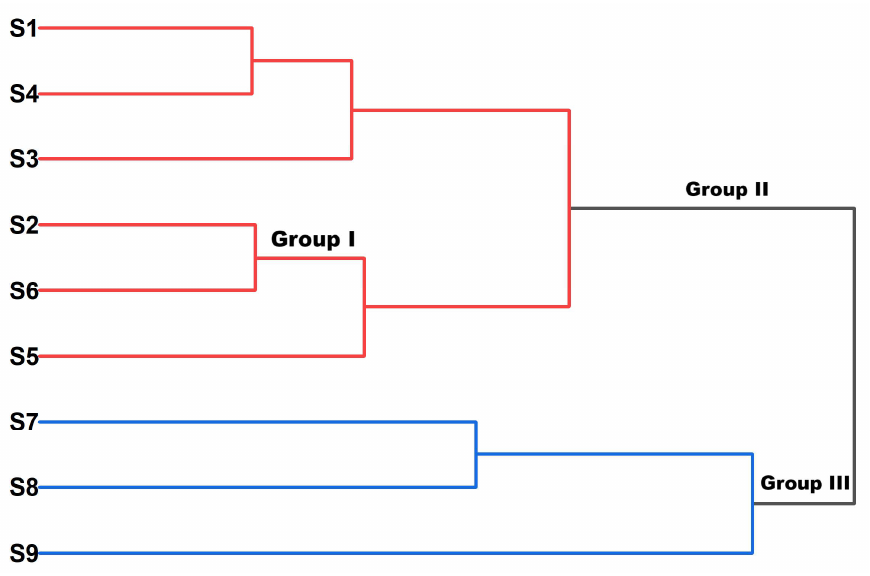
Figure 8. Cluster analysis of SHFs from the nine strains.